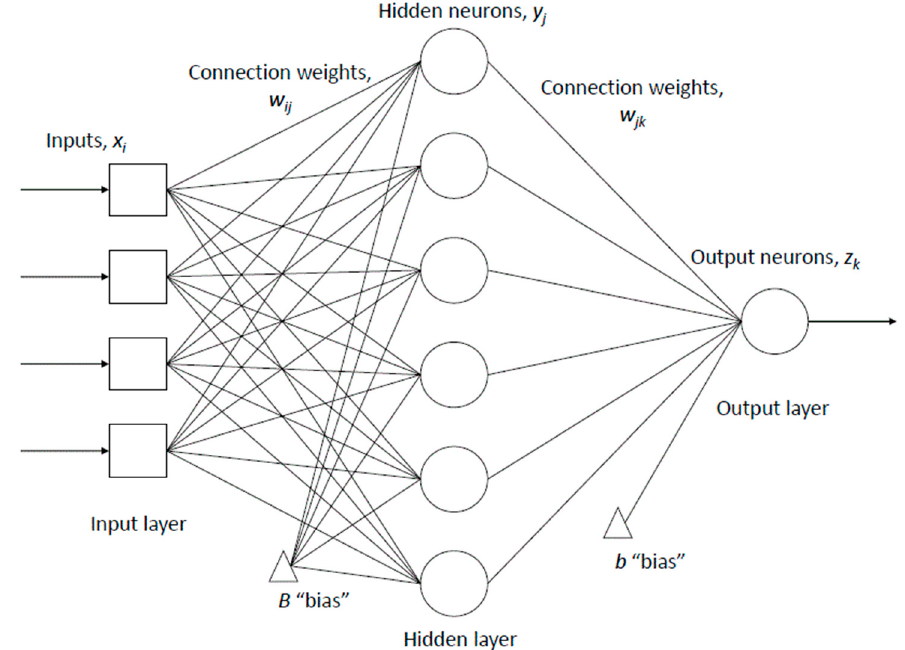
Figure 9. Artificial neural network structure diagram.